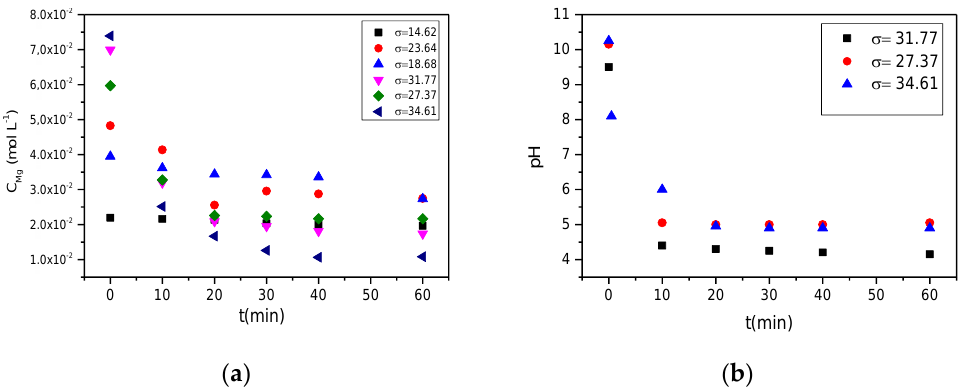
Figure 3. ( a ) Magnesium concentration as a function of time during the precipitation of struvite and ( b ) change in pH for struvite precipitation; the magnesium source was the suspension obtained for the hydrothermal treatment of MgO (Method A); 25 °C.